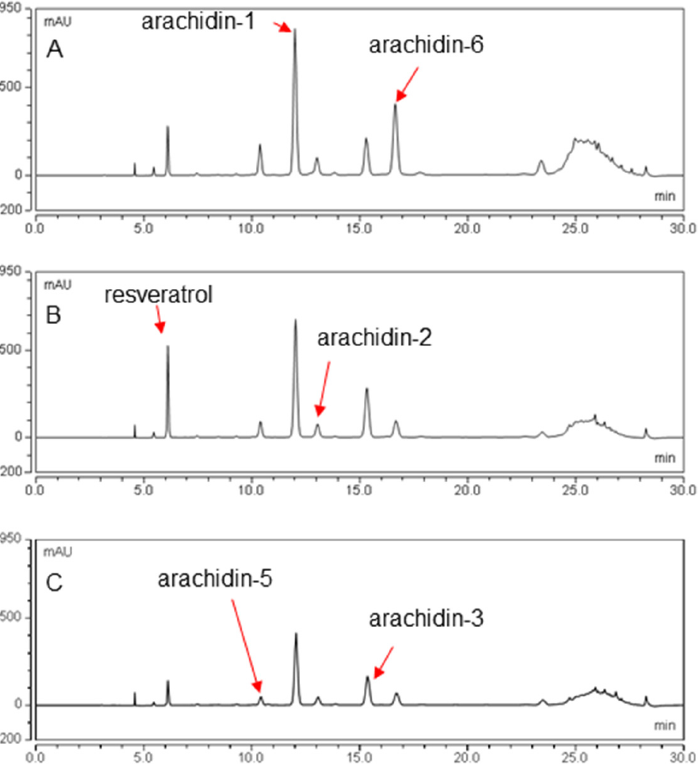
Figure 4. Comparison of secreted stilbenoid profiles among three different cultivars of peanut hairy root cultures. HPLC chromatograms of culture medium extract of hairy root cultures of ( A ): Peanut cv. Tifrunner; ( B ): Peanut cv. Hull line 3; ( C ): Peanut cv. Georgia Green after 168 h elicitor treatment. All chromatograms were monitored at 340 nm.